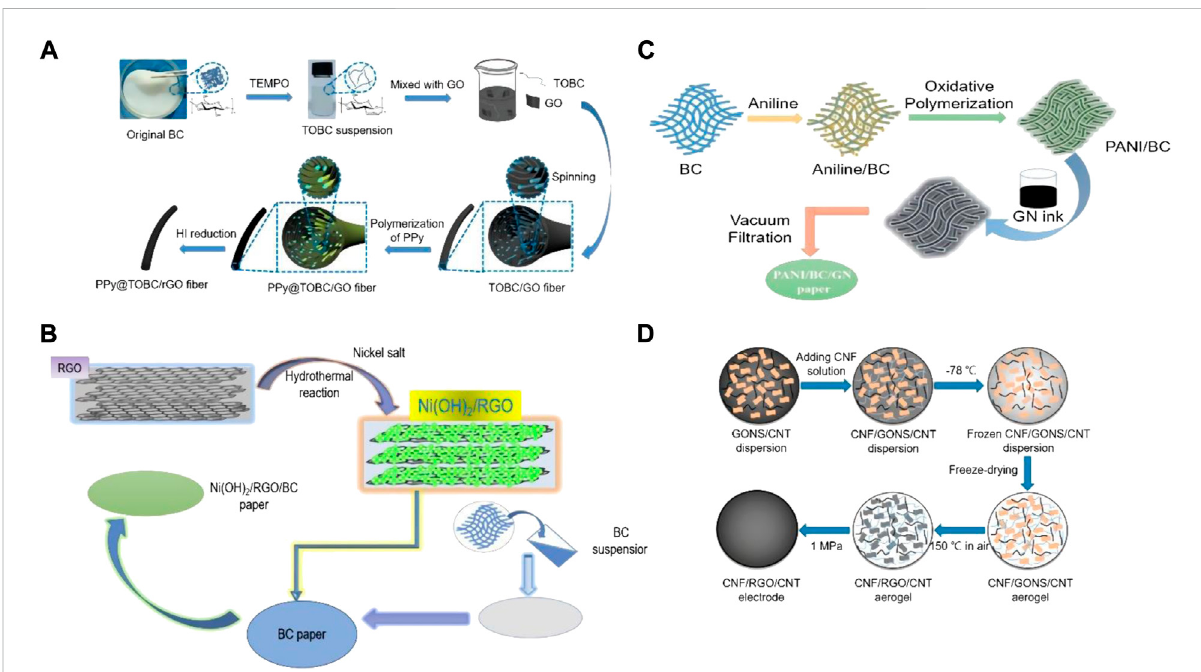
FIGURE 7 The preparation process of the (A) PPy@TOBC/rGO macro fi bers, (B) Ni(OH) 2 /RGO/BC electrode, (C) PANI/BC/GN freestanding paper electrodes, and (D) CNF/RGO/CNT electrode. Reproduced from: (A) Sheng et al. (2019), Elsevier. (B) Ma et al. (2016a), Elsevier. (C) Liu et al. (2016), Royal Society of Chemistry. (D) Zheng et al. (2015), American Chemical